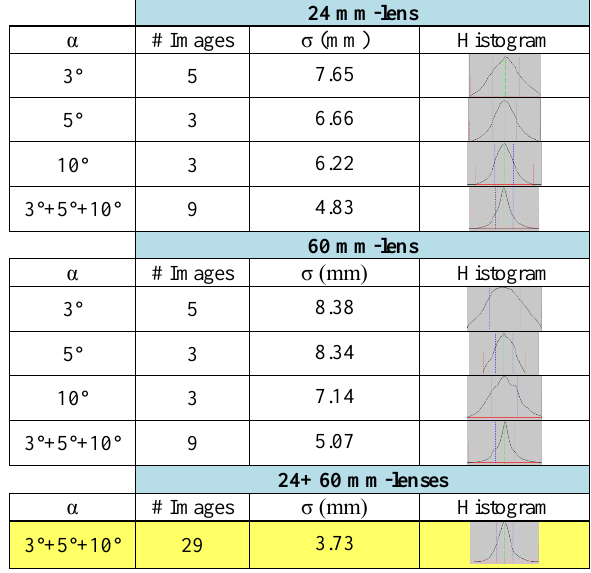
Table 2. Statistics delivered by inter-comparisons performed on